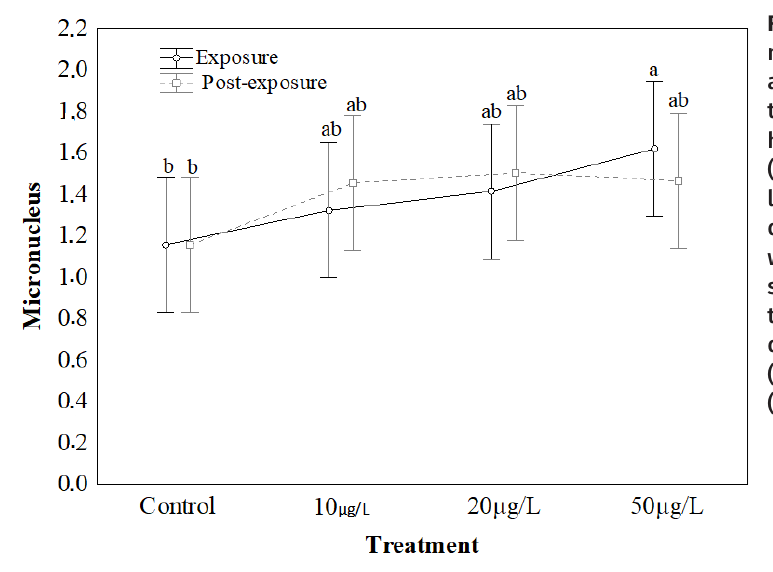
Figure 1. Mean frequency of micronuclei in R. catesbeiana after 96 hours of exposure to Elatus® (Exposure) and 96 hours after the end of exposure (Post-exposure). Different letters indicate a significant difference, while values marked with the same letters are statistically similar according to the factorial ANOVA test. The data are presented as mean (circles) and standard deviation (vertical